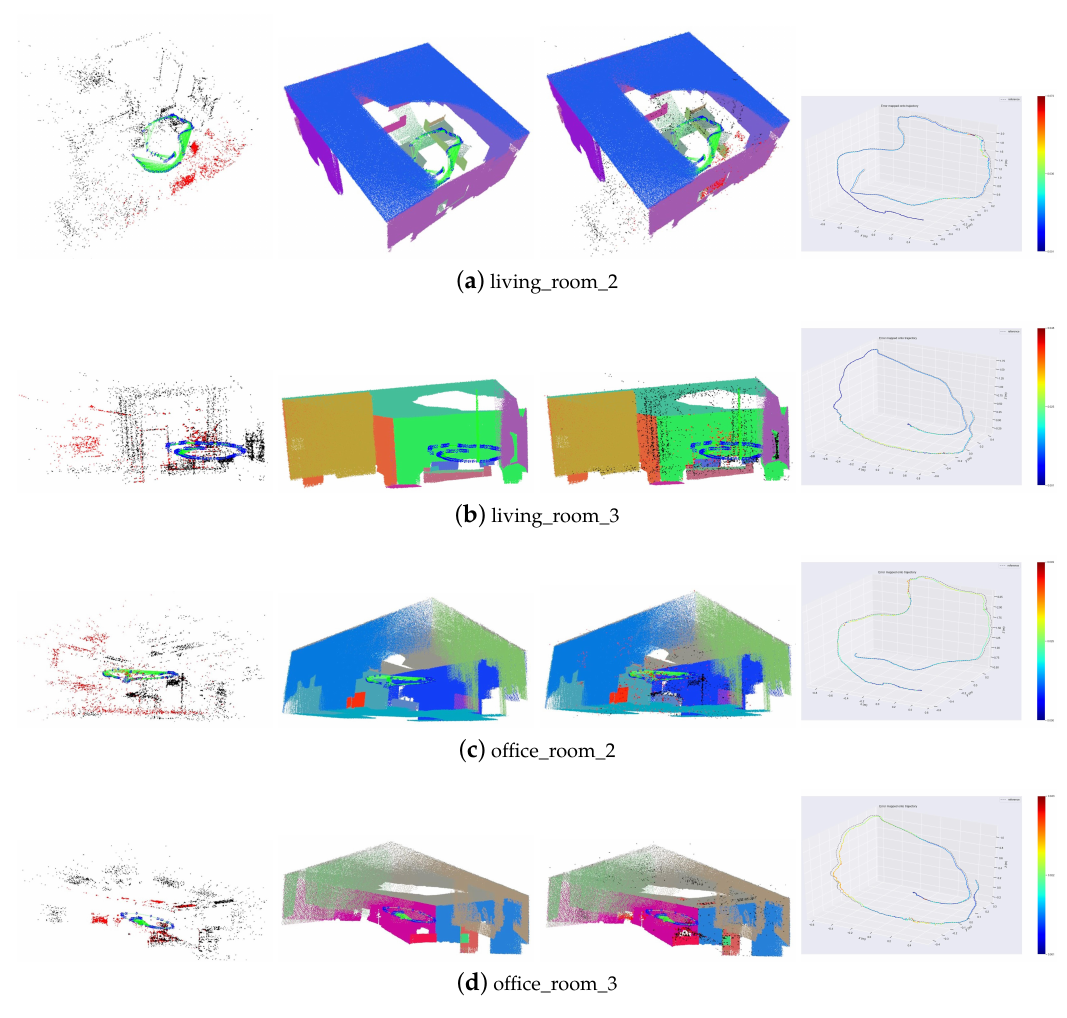
Figure 8. Trajectories and reconstruction results. The first column is the point landmarks and the camera trajectories. The second column shows the plane landmarks. The third column shows the plane and point landmarks together. The fourth column is the comparison of the estimated trajectories and corresponding ground